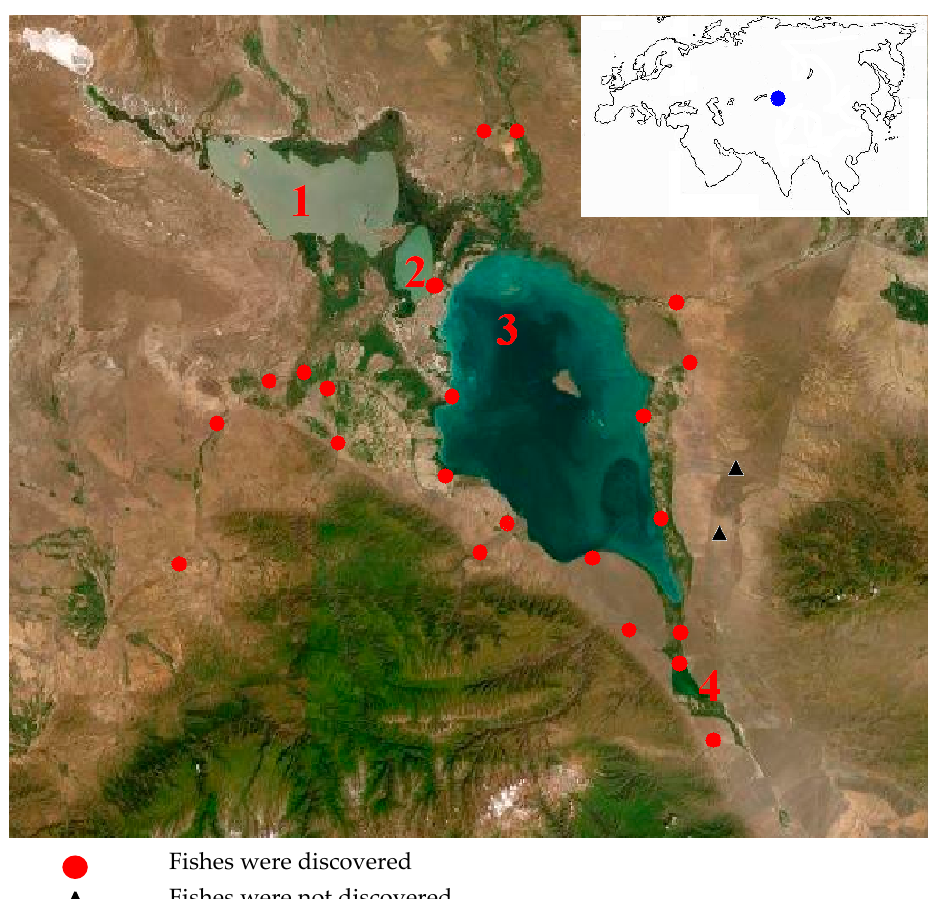
Figure 1. Schematic map of the investigated region: 1—Sasykkol Lake, 2—Koshkarkol Lake, 3— Alakol Lake, 4—Zhalanashkol Lake. The blue point shows the position of the Alakol Lakes in Eur- asia.